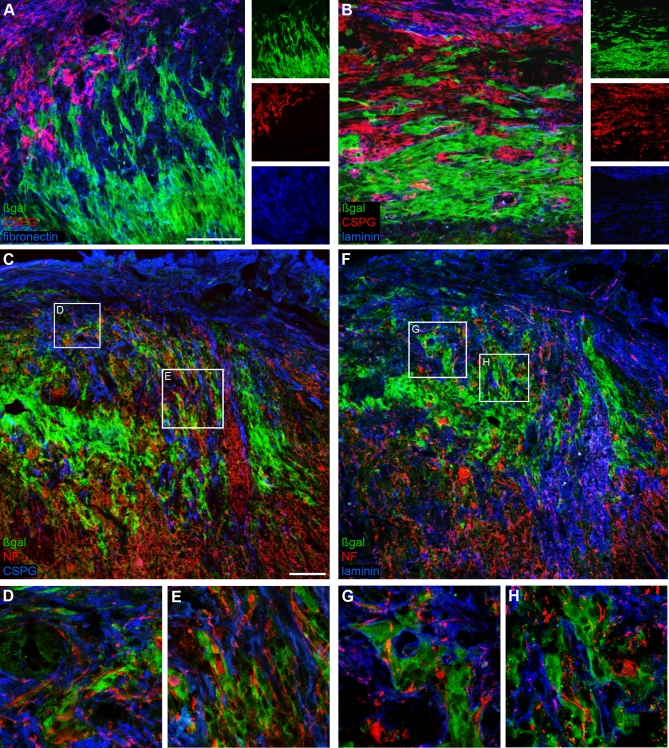
Relationship between Ependymal Cell-Derived Progeny, Axonal Growth-Modulating Molecules, and Axons in the Scar Tissue(A–E) Chondroitin sulphate proteoglycans (CSPG), which are axonal growth inhibitory, are abundant in the scar tissue 2 wk after a dorsal funiculus lesion. CSPG are present in a complementary and nonoverlapping pattern to β-gal–expressing ependyma-derived cells. The extracellular matrix proteins fibronectin (A) and laminin (B and F), which are permissive to axonal sprouting, are widely distributed within the scar tissue and overlap with β-gal–expressing ependyma-derived cells. (C–H) Neurofilament (NF)-immunoreactive axons in the scar tissue are rarely present in CSPG+ areas (C–E) but are associated with ependymal cell progeny (C–H) and laminin (F–H) in the core of the forming scar tissue 2 wk after injury. Scale bars indicate 100 μm.